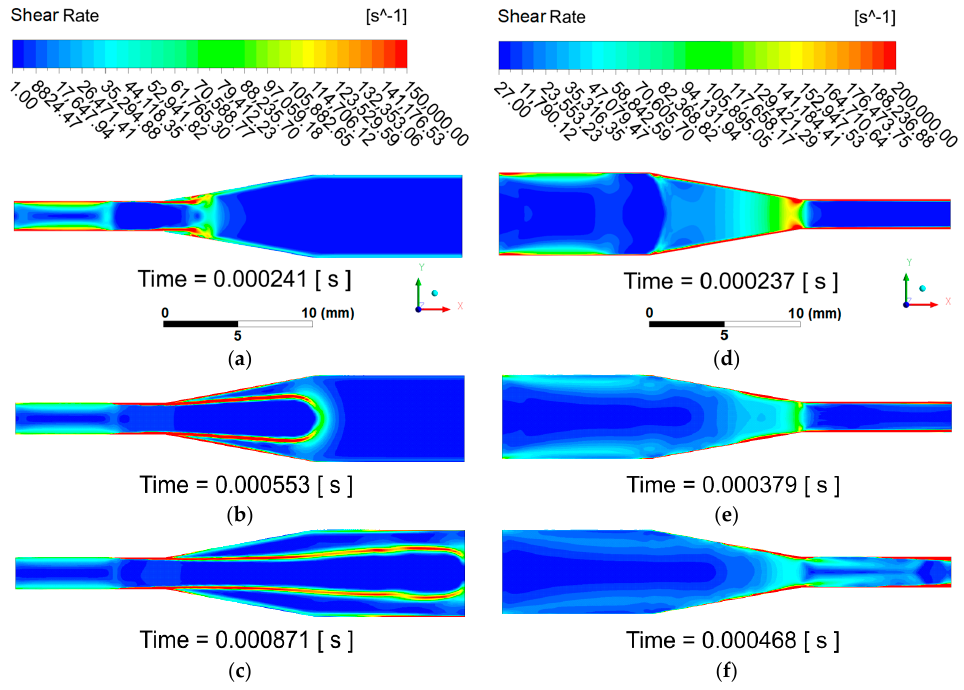
Figure 12. Shear-rate results of ( a ) diffuser case in the first selected timestep, ( b ) diffuser case in the second selected timestep, ( c ) diffuser case in the third selected timestep, ( d ) confusor case in the first selected timestep, ( e ) confusor case in the second selected timestep and ( f ) confusor case in the third selected timestep.